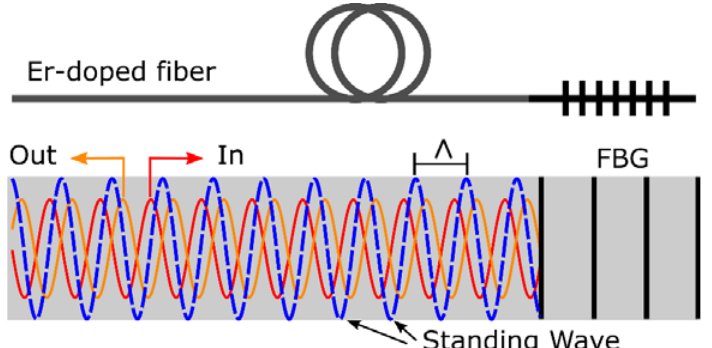
Figure 1. Schematic description of Fiber Bragg Gratings (FBG) induced by Spatial Hole Burning (SHB) with stationary wave on Er-doped fibers. Both incoming and outgoing waves create a standing wave that makes a periodic variation of the refraction index whose period matches the seed FBG.